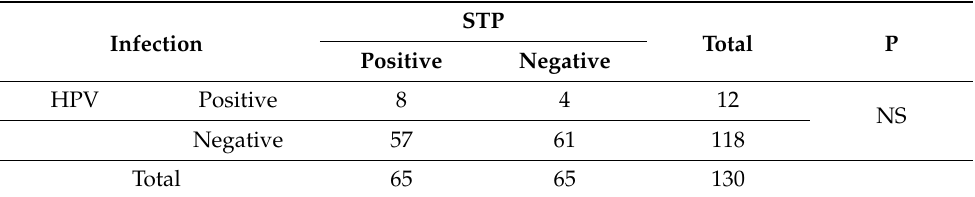
Table 3. Association between the prevalence of HPV infection and an STP-positive result in male urine